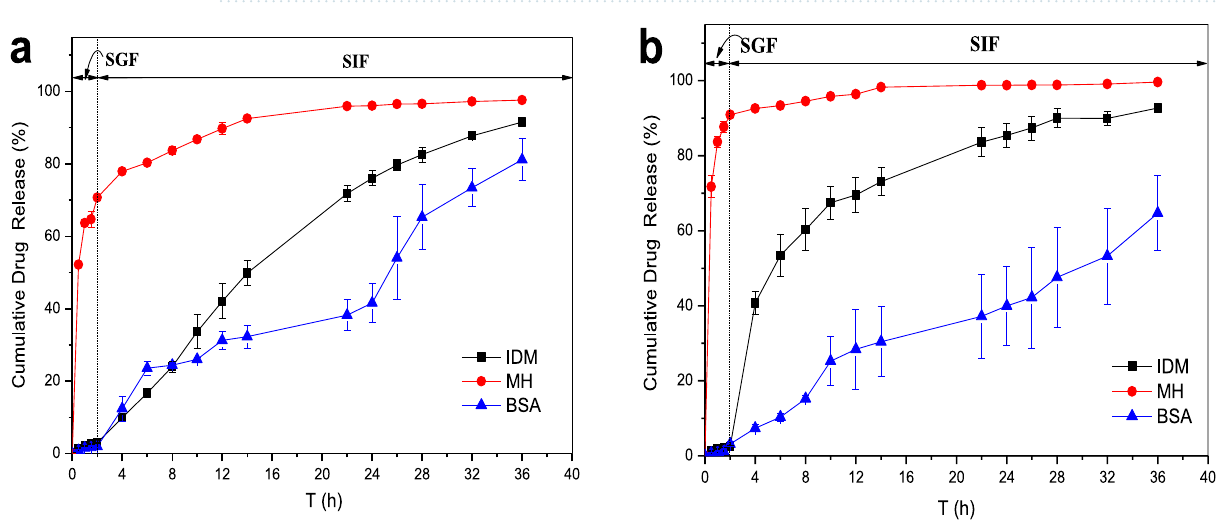
Figure 10. Effect of inner matrix composition on the cumulative drug release behavior of double layer hydrogels in simulated gastrointestinal fluid [( a ) SA-CMC@PDMA-1; ( b )